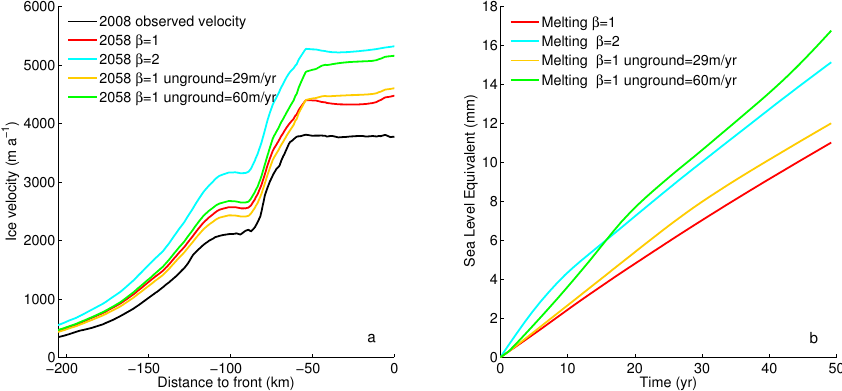
Figure 9. Modeled velocity sensitivity (a) and volume above floatation sensitivity (b) to ice shelf melting applied over newly ungrounded areas.